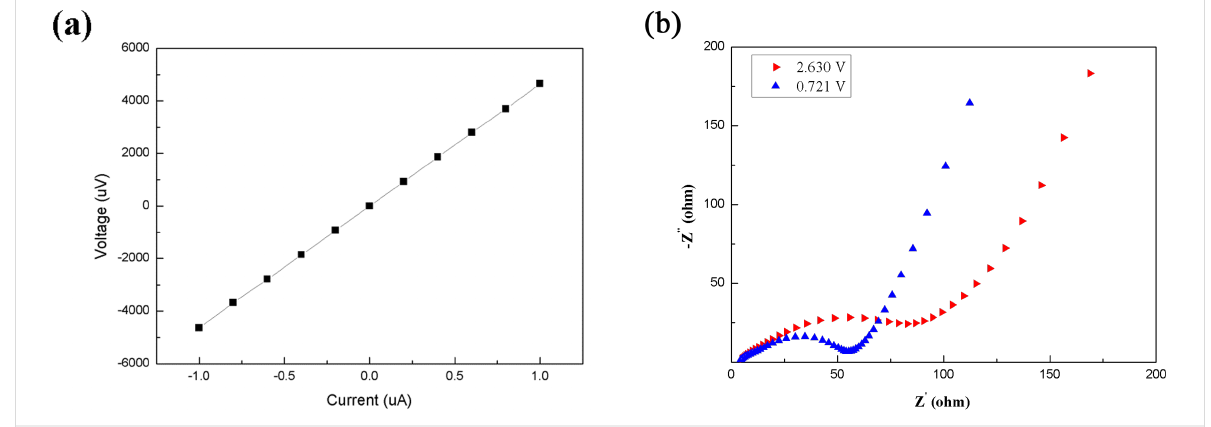
Figure 3: (a) I – V curve of the as-prepared Si film on glass substrate. (b) Nyquist plots of the Si electrode at 2.630 V and 0.721 V.